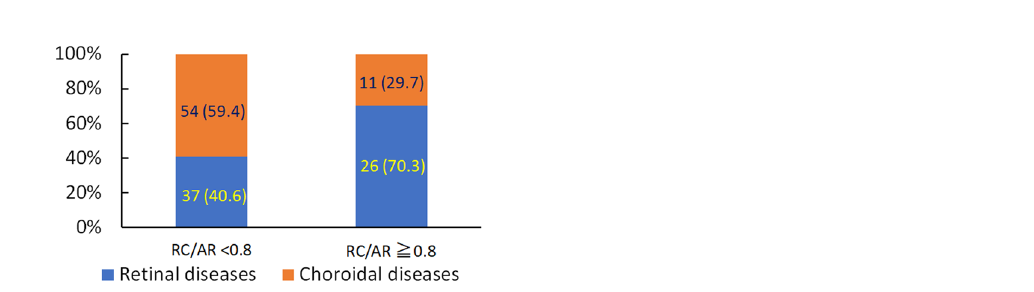
Figure 2. Numbers of patients with retinal and choroidal diseases who had a retinal circulation time/arm-to- retina time ratio < 0.8 or ≥ 0.8. Eyes (%). RC/AR retinal circulation time/arm-to-retina time